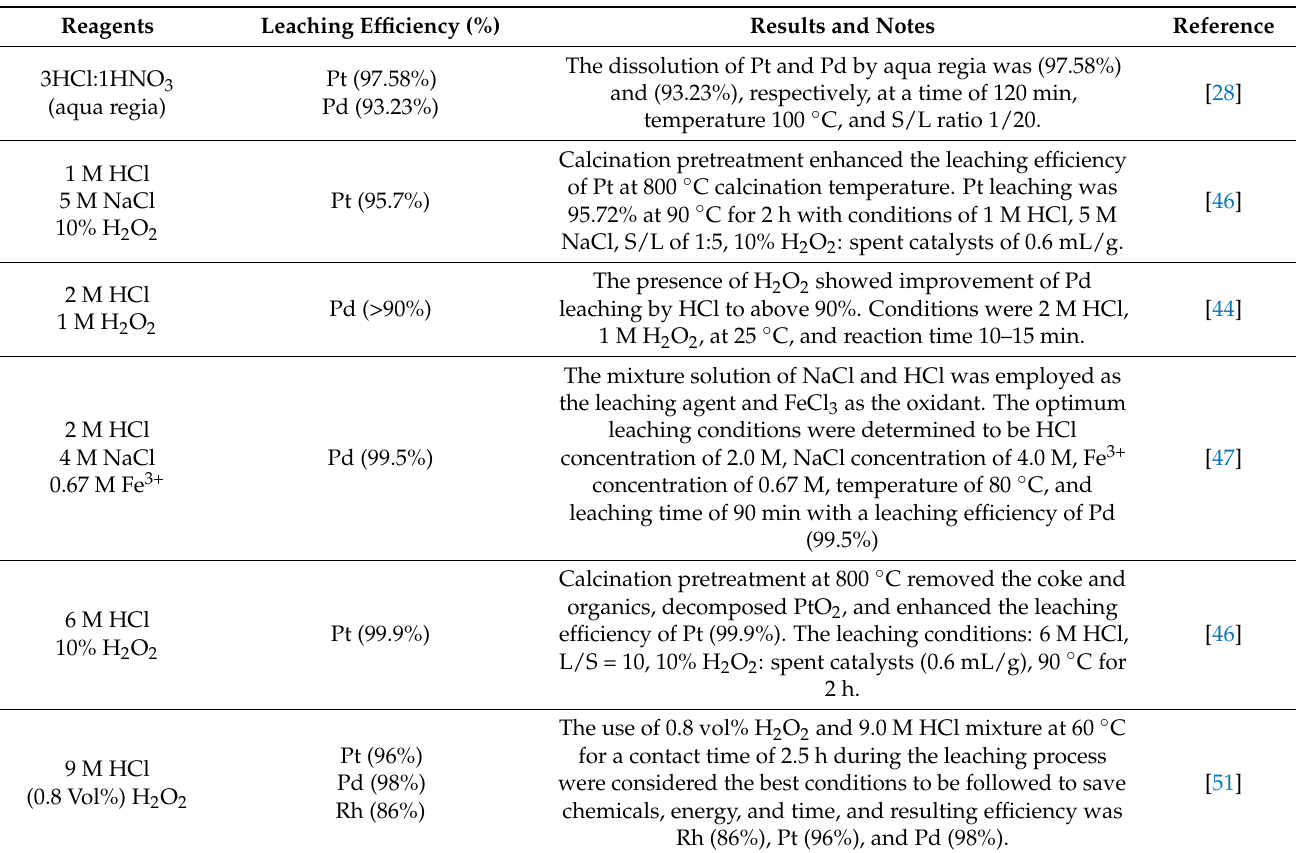
Table 3. Summary of the leaching process of PGMs from spent catalytic